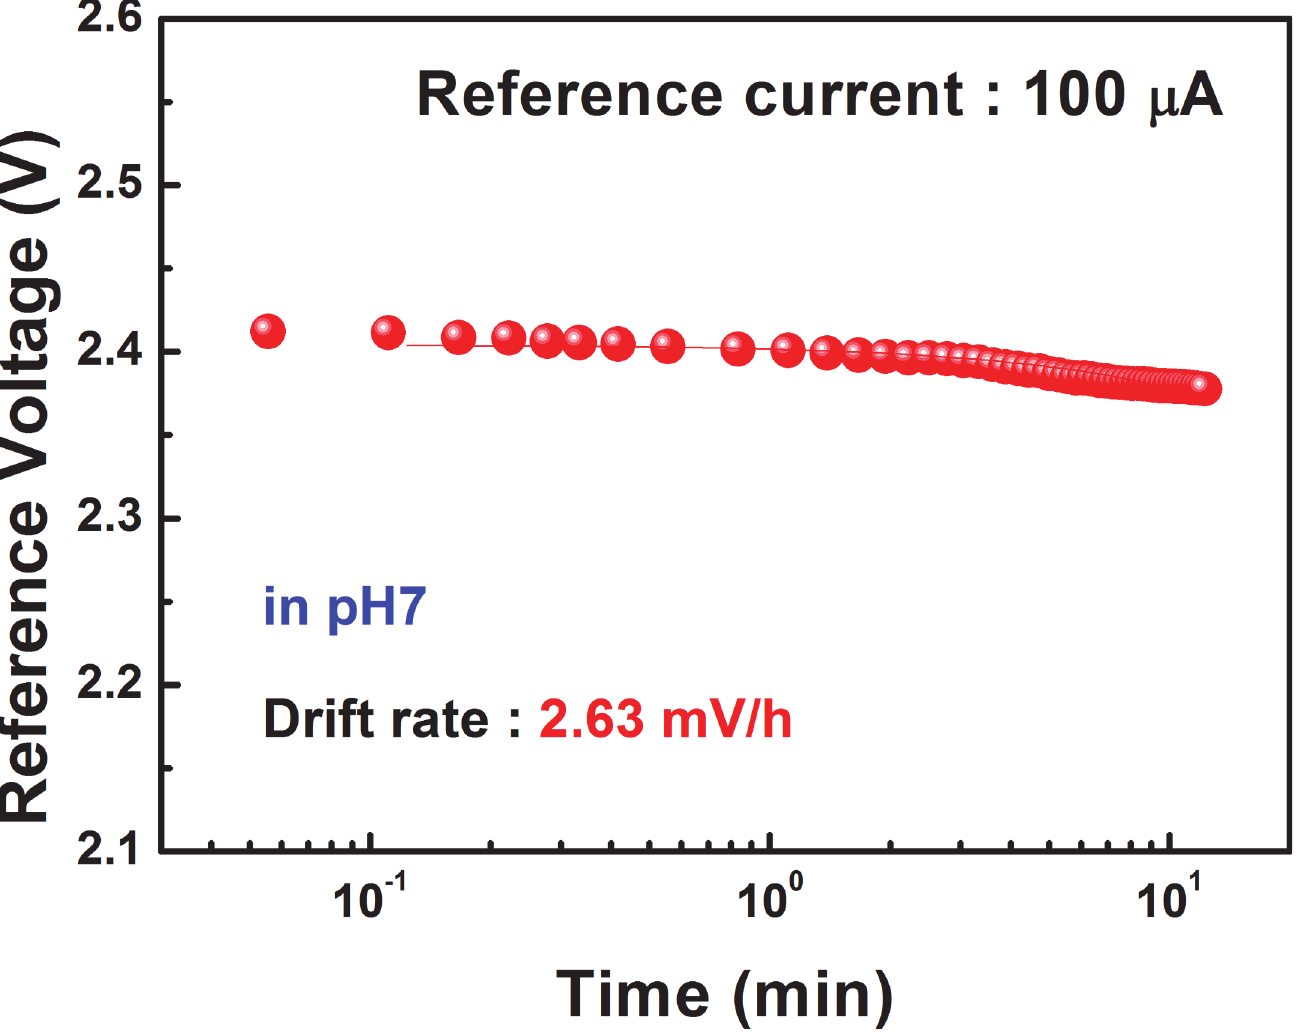
Fig 3. Drift rate of SnO 2 membrane in a solution with pH 7. The reference voltage (V) is shown as a function of pH evaluated at a reference current of 100 μ